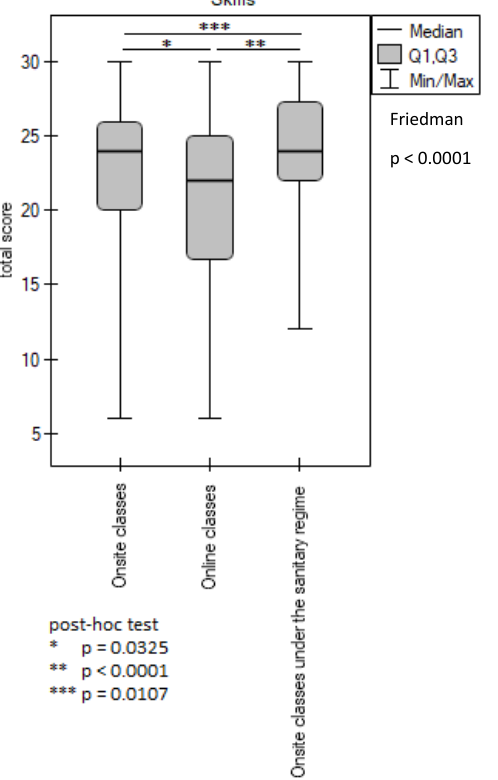
Figure 2. Evaluation of the achieved learning outcomes in the scope of skills. *, **, *** p -value is given for statistically significantly different groups. Moreover, 69.43% of the respondents rated the onsite classes positively, 79.05% rated the onsite classes under the sanitary regimen positively, and 55.86% rated the